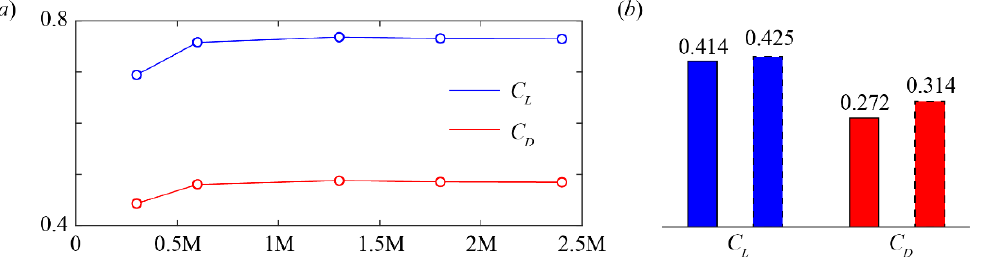
Figure 4. Validation of the numerical method. Unit M in ( a ) denotes a million and the experimental data in ( b ) is outlined by dotted lines.